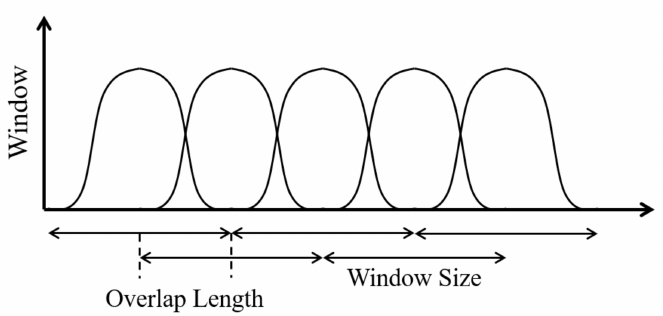
Figure 1. Window size and overlap length of the window function for